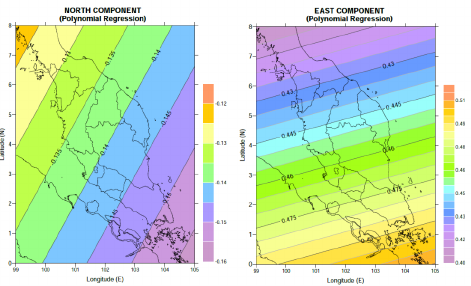
Fig. 15. GDM2000(REV 2006) to GDM2020: Northing and Easting cadastral coordinates shifts for Peninsular Malaysia in meter.